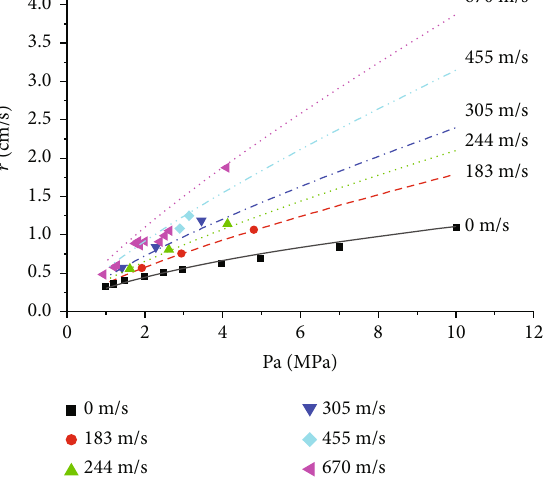
Figure 1: Propellant